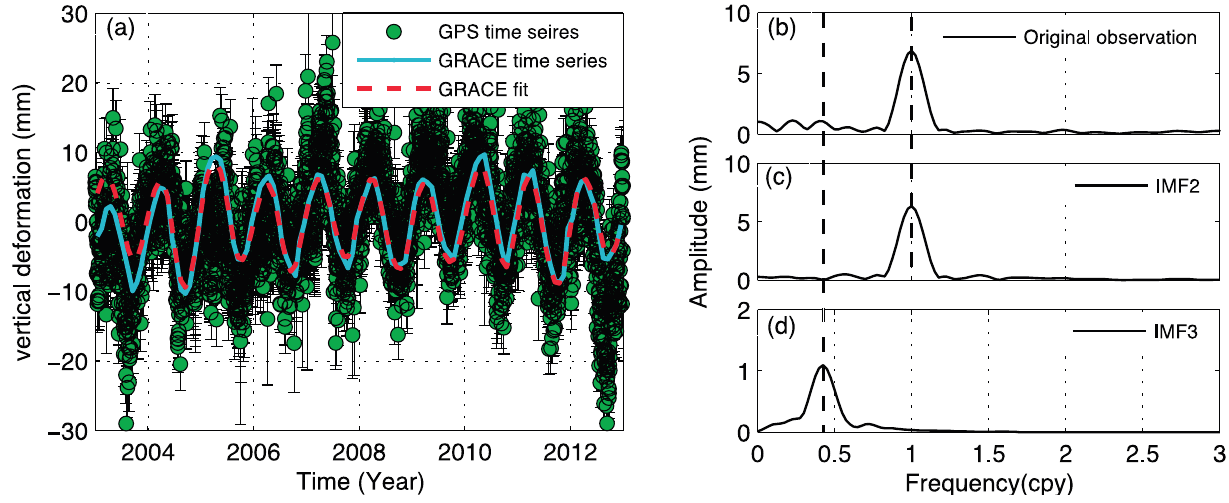
Figure 8. The example de-trended time series for continuous GPS site LHAZ (green error bar), monthly displacement time series of GRACE result is cyan curve in ( a ) correspondent to its amplitude spectrum curve in ( b – d ) are annual and quasi-biennial signals decomposed by EEMD. The GRACE fit curve is added by IMF2 and